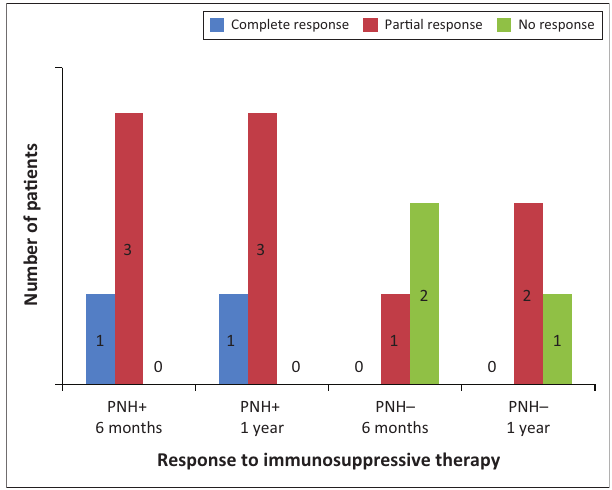
FIGURE 3: Response to immunosuppressive therapy among paroxysmal nocturnal haemoglobinuria population-positive and paroxysmal nocturnal haemoglobinuria population-negative patients at the Inkosi Albert Luthuli Central Hospital, Durban, South Africa, September 2013 – January